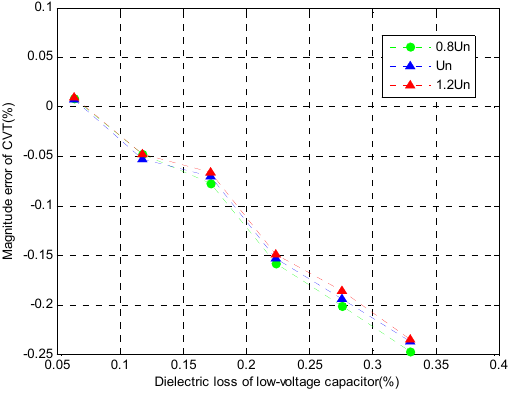
Figure 21. CVT magnitude error with different low-voltage capacitor dielectric loss factor.